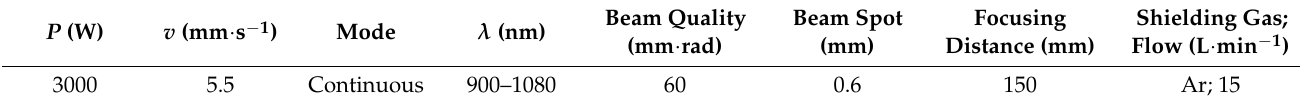
Table 2. Welding